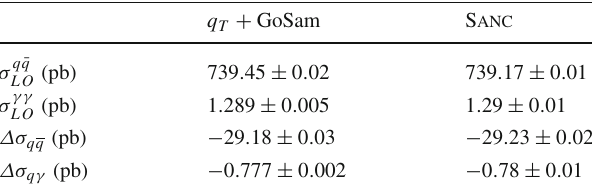
Table 1 Comparison of NLO EW corrections to Drell–Yan dimuon production ( m l ≡ m μ = 105 . 658369MeV) computed with q T sub- traction and with the Sanc generator. In the q ¯ q channel the q T result is obtained with a linear extrapolation in the r cut → 0 limit (see Fig. 2), while in the q ( ¯ q )γ channel it is obtained at r cut = 0 . 01%. The LO result in the q ¯ q and γγ channels is also reported for reference. The ¯ q cross section, below 0 . 5 per mille , can be small discrepancy in the σ q LO ascribed to the use of the complex mass scheme in our